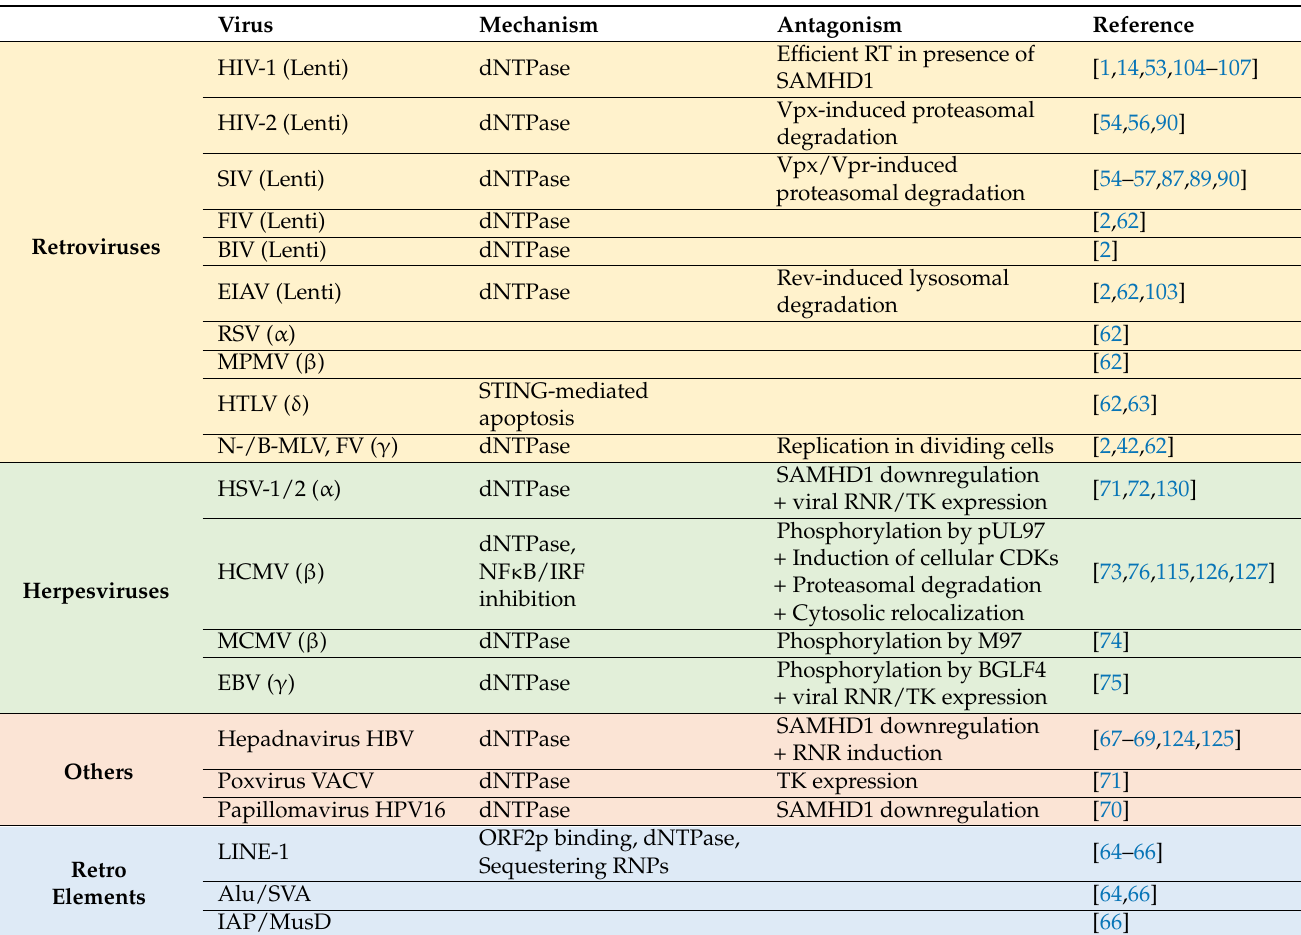
Table 1. Viral SAMHD1 evasion